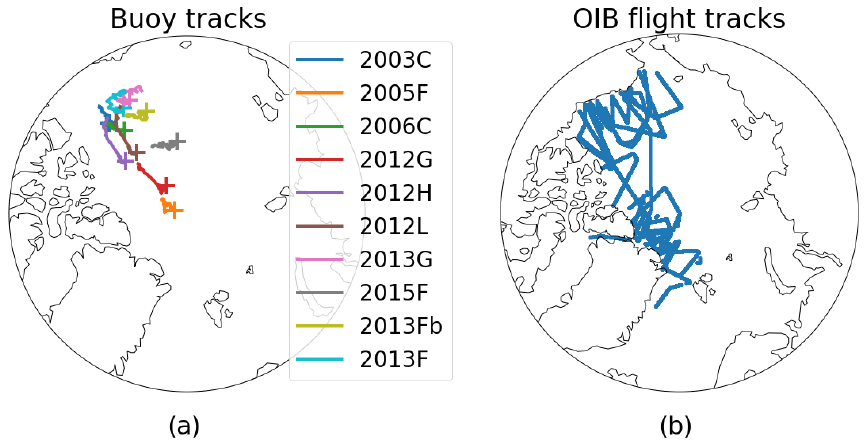
Figure 1. Tracks traveled by (a) ice mass balance buoys and (b) Operation IceBridge flights used in this study. Initial buoy location is signified with a plus symbol, and all buoy tracks from 1 November to 1 April are shown. Table 1. A listing of United States Army Corps of Engineers Cold Regions Research and Engineering Laboratory (CRREL) ice mass balance buoys used in this work. All buoys from 2003 to 2016 containing a full season of sea ice thickness growth are included, excluding those in landfast ice or showing obvious dynamic